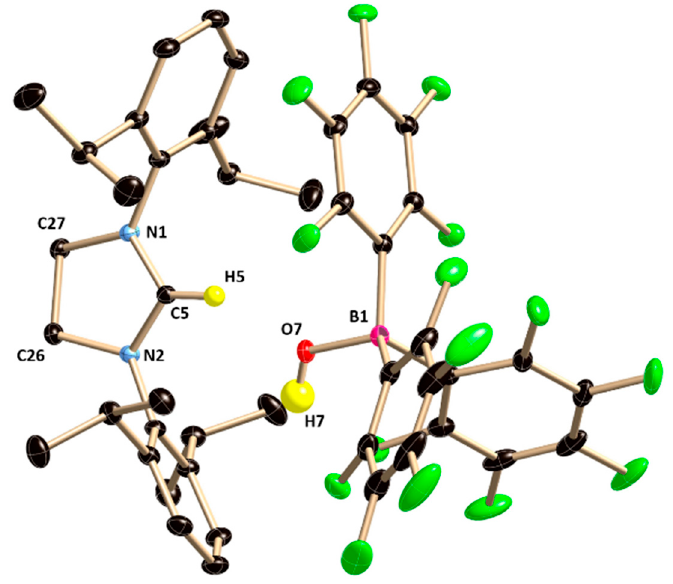
Figure 8. The molecular structure of 8 . Hydrogen atoms except the H5 and H7 are omitted for clarity.